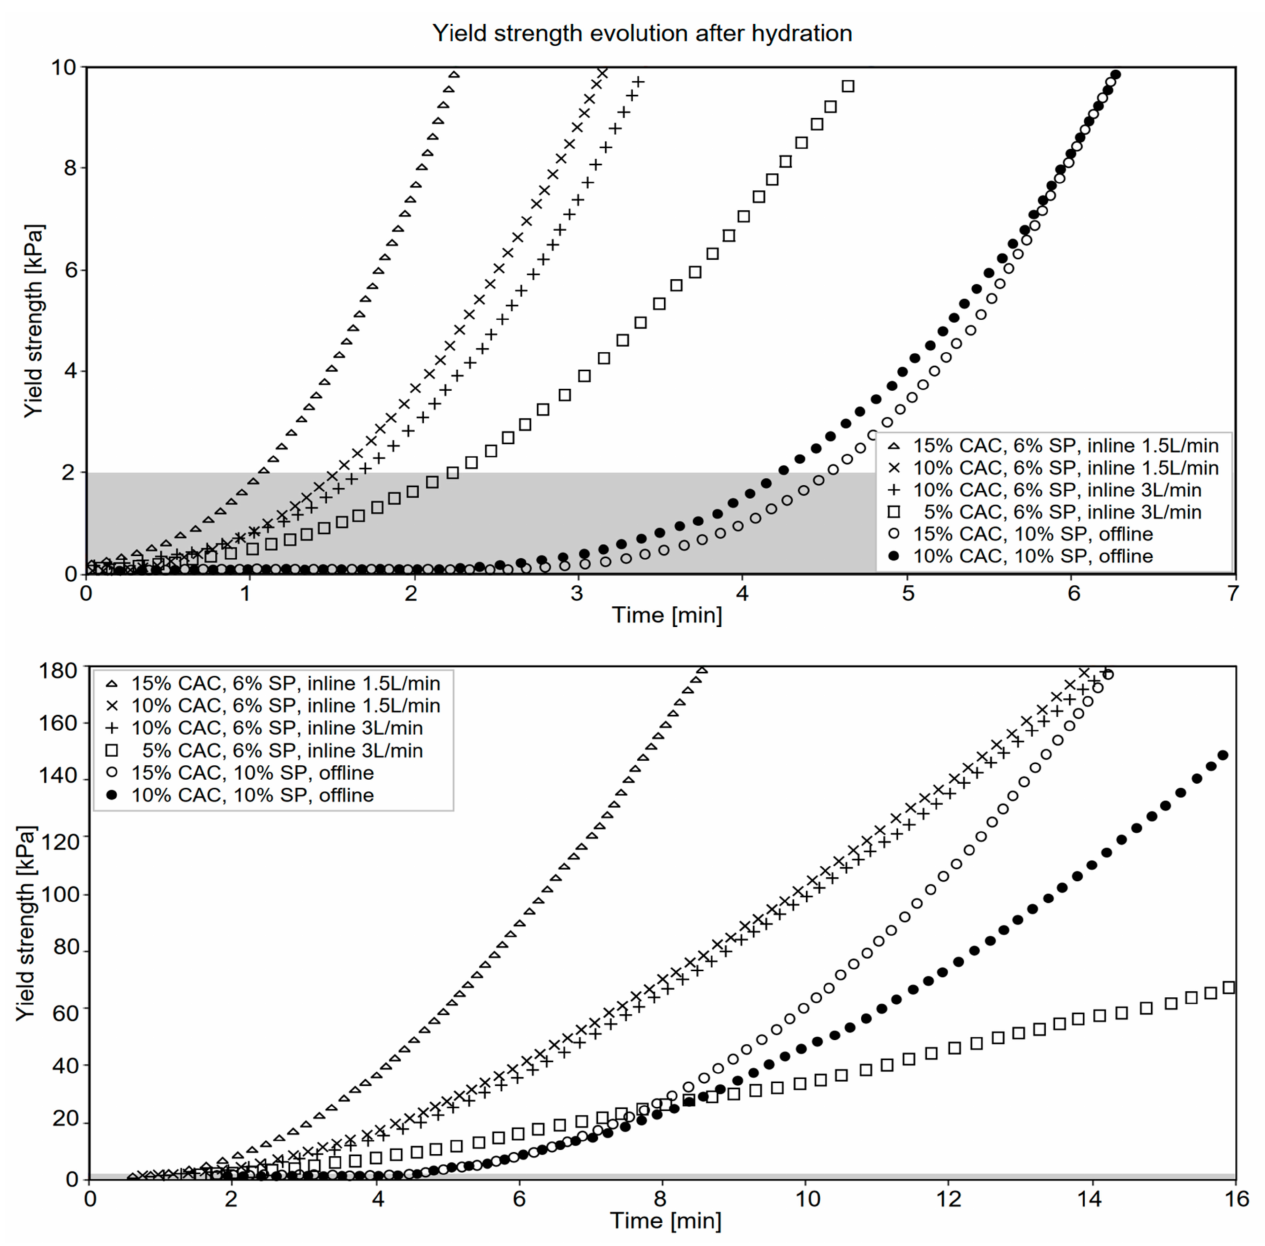
Figure 5. Initial strength development ( period I ). Material strengths after hydration beginning within the first ( top ) 7 min and ( bottom ) 15 min measured by a penetration